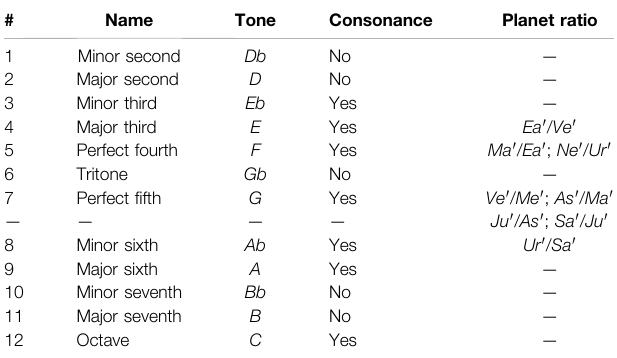
TABLE 5 | Comparison between the 12 tones and the semimajor axis ratios among the adjacent planets raised to the k (cid:1) 2/3 power deduced from the corrected Geddes – King-Hele planetary distance equations ( Eq. 13 ). The tone is that of the inner planet of the pair when the outer planet is tuned to C. (Refer to Table 1 for the numerical values of the tones).